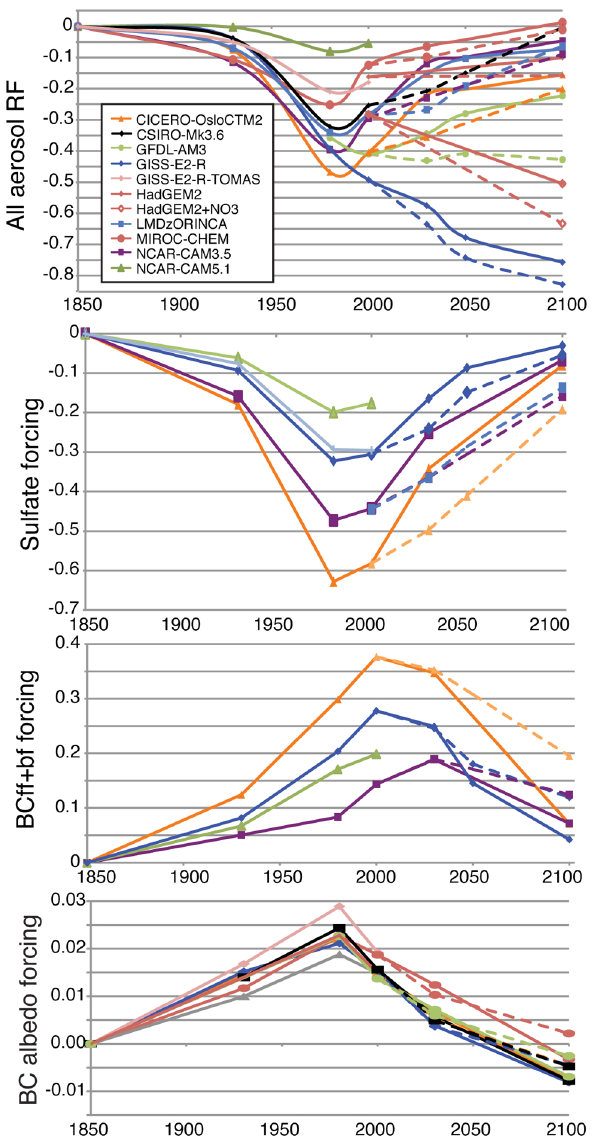
Fig. 10. Timeseries of global mean annual average RF from all aerosols (top), sulfate (2nd row), fossil + bio fuel BC (3rd row) and BC albedo (bottom) in the indicated models. RF was calcu- lated at the years with symbols and is interpolated for other years. Open symbols for HadGEM2 show the results incorporating nitrate aerosols as described in Bellouin et al. (2011). RCP8.5 is shown as dashed lines, RCP2.6 as solid